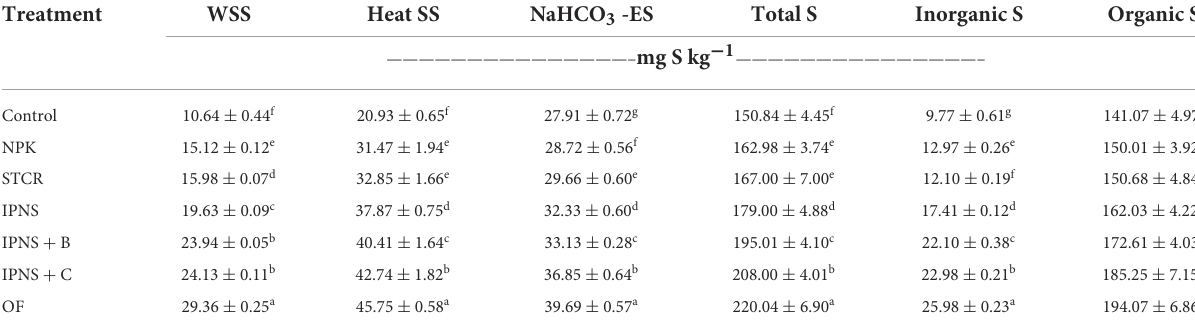
TABLE 2 Impact of long-term integrated plant nutrition system (IPNS) options on soil sulfur fractions in the 0–15cm soil layer of rice-wheat cropping system (RWCS). Treatment